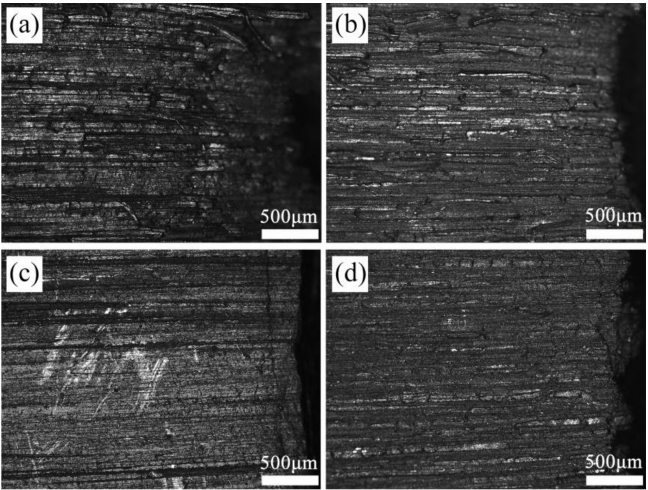
Figure 9. Surface morphologies of two aged alloys failed at different strain rate in 3.5% NaCl solution at